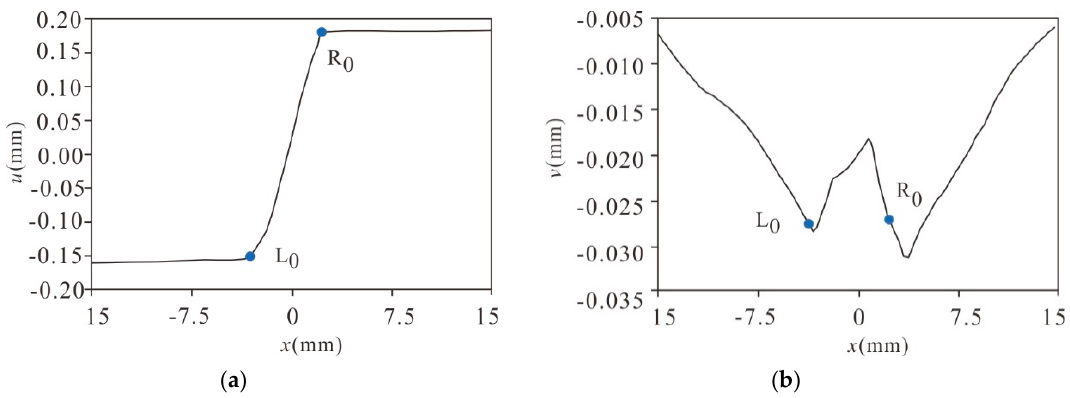
Figure 10. Displacement on line A 0 B 0 of specimen 0.3-3 at loading P5: ( a ) opening displacement, ( b ) sliding displacement.